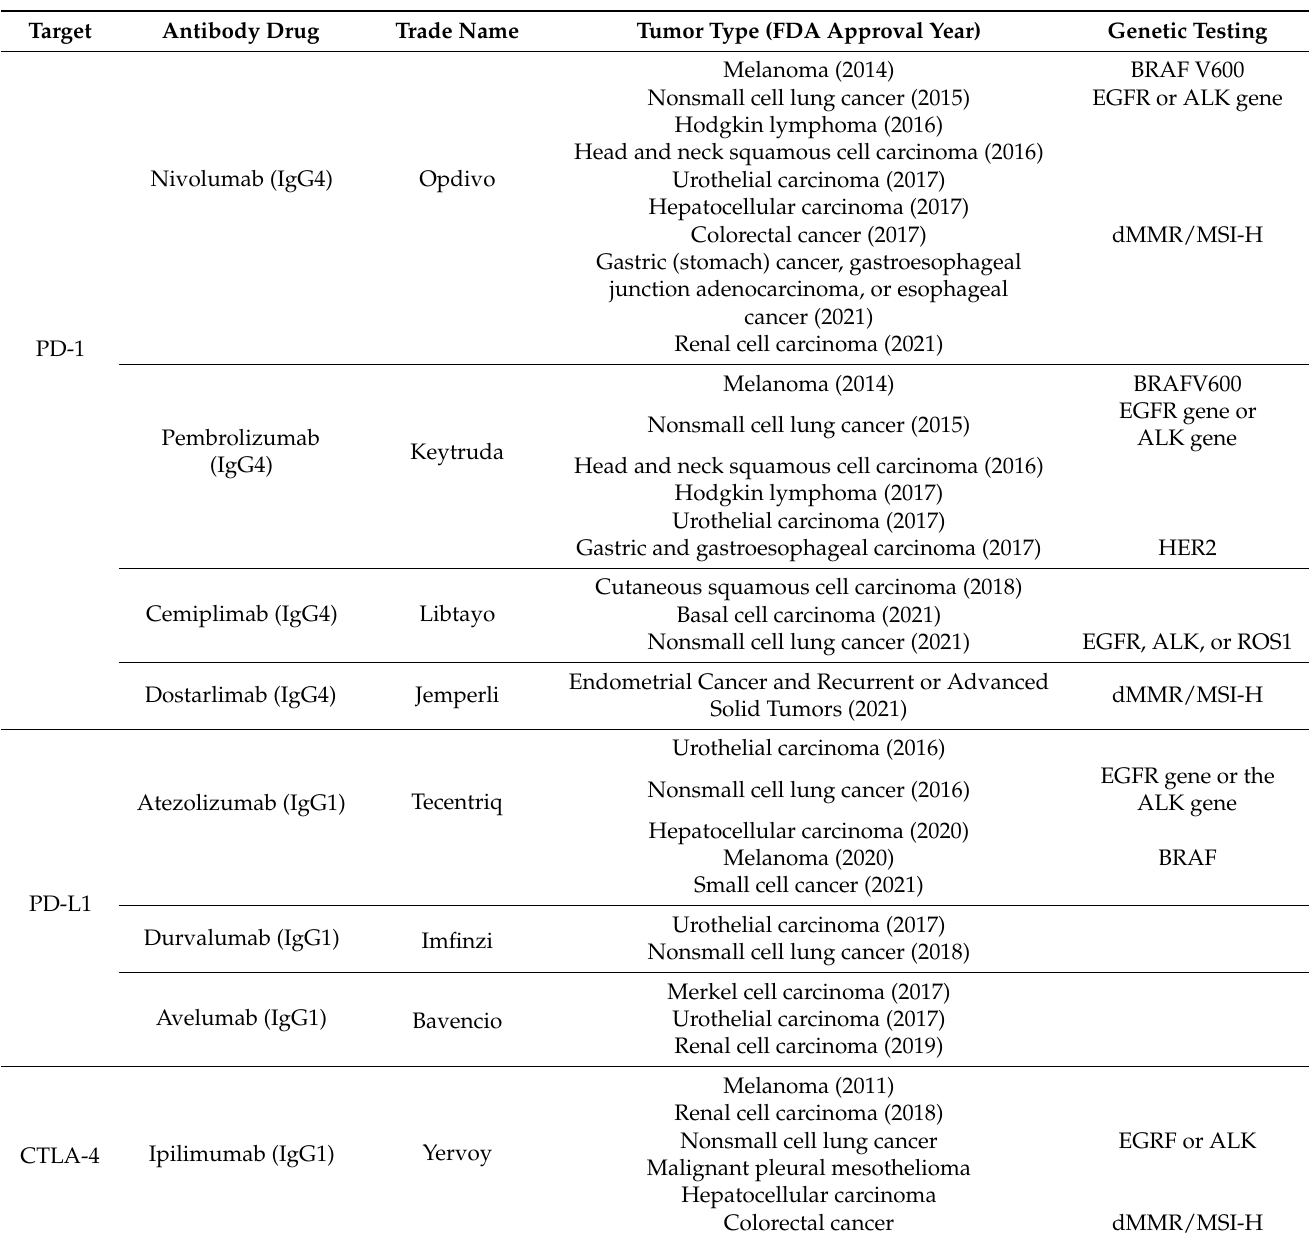
Table 1. FDA-approved immune checkpoint blocking